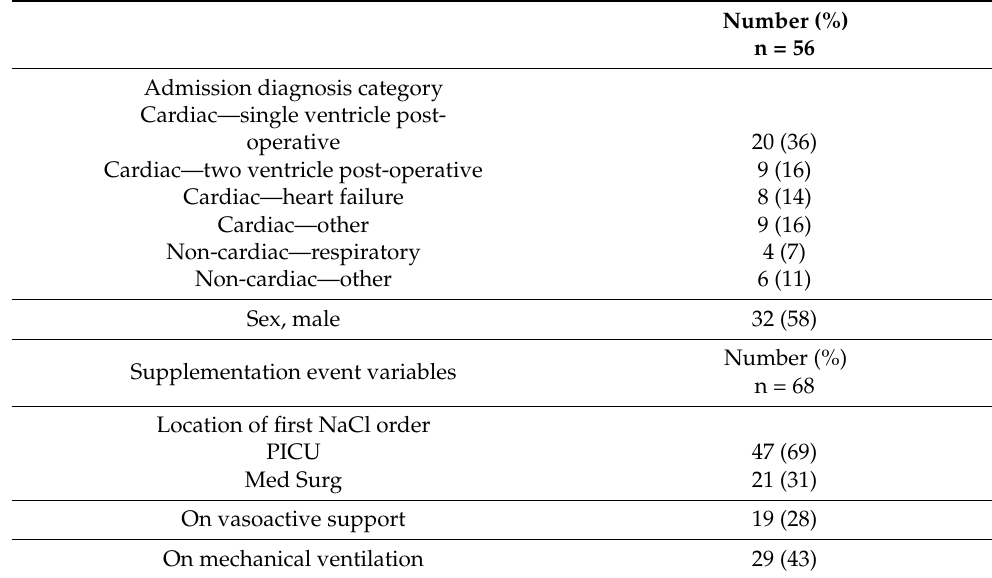
Table 1. Patient demographic data.